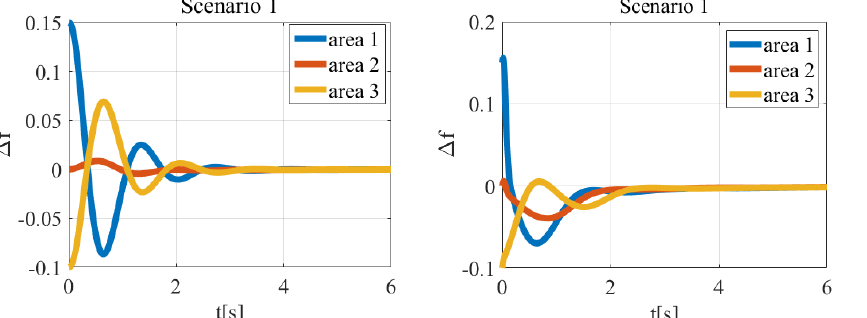
Figure 10. The time responses of ∆ f with LQR ( left figure) and fuzzy controller ( right figure) for different areas—scenario